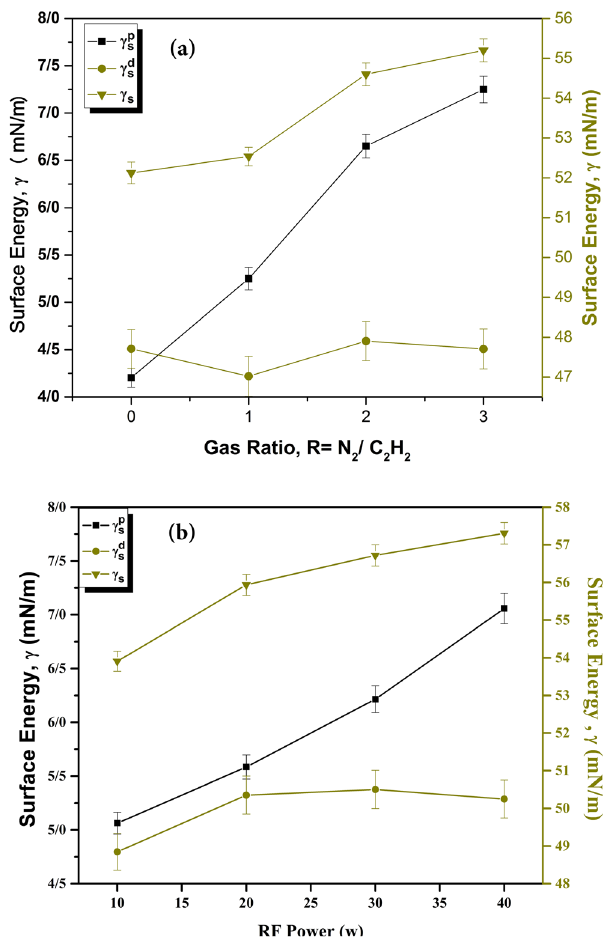
Figure 6. Variation of SFE and its polar and dispersive components in function of ( a ) gas flow rate in R = 1 and ( b ) RF power in 20